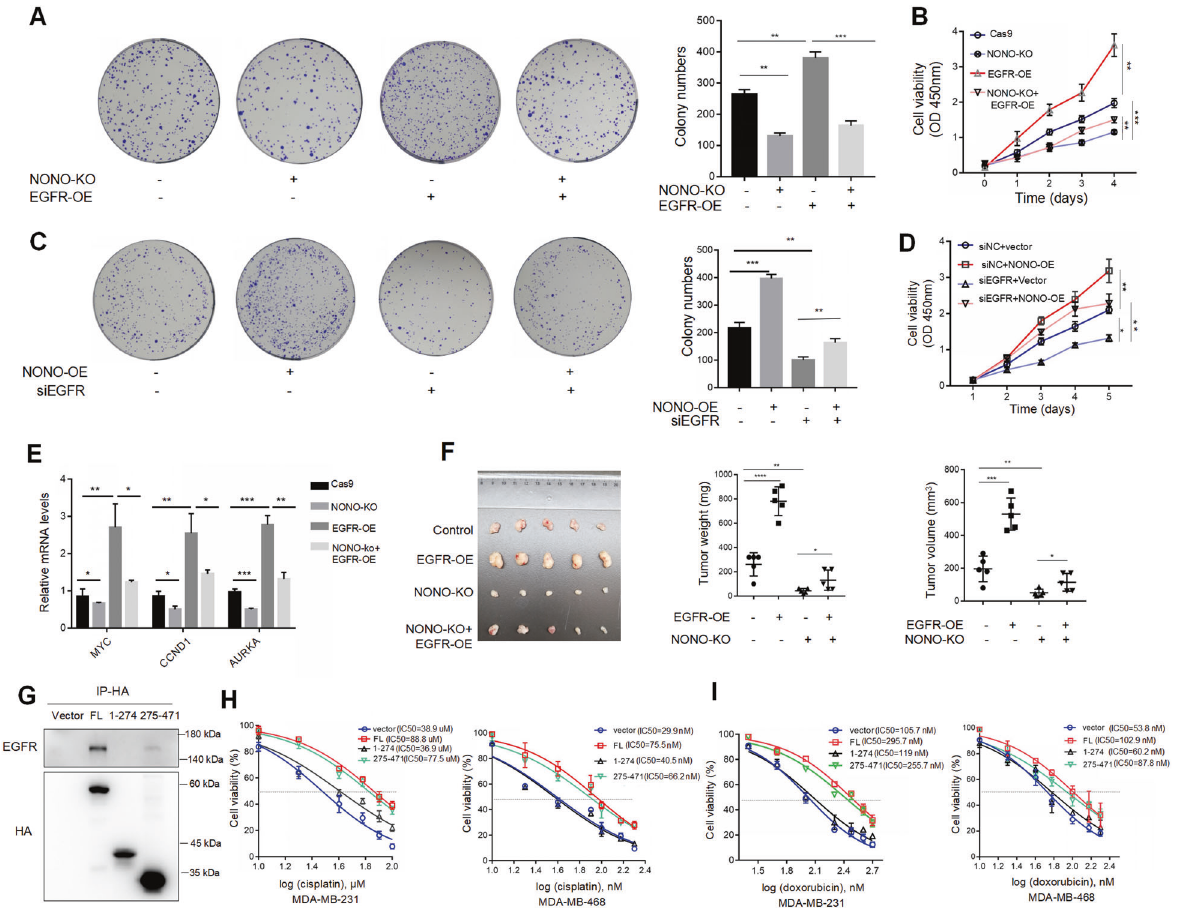
Fig. 7 Nuclear EGFR/NONO complex is important for the malignant progression of TNBC. A Colony formation was used to analyze the effect of overexpressing EGFR on the cell viability of MDA-MB-468 with NONO knockout or not. B CCK-8 was used to analyze the effect of overexpressing EGFR on the cell proliferation of MDA-MB-231 with NONO knockout or not. C Colony formation was used to analyze the effect of overexpressing NONO on the cell viability of MDA-MB-468 with EGFR knockdown or not. D CCK-8 was used to analyze the effect of overexpressing NONO on the cell proliferation of MDA-MB-231 with EGFR knockdown or not. E RT-qPCR was used to analyze the effect of overexpressing EGFR on the mRNA levels of indicated genes in the absence of NONO in MDA-MB-231. F Image of xenograft tumors resected from tumor-bearing mice that injected subcutaneously with indicated cells ( n = 5 per group). G The Functional domain of NONO responsible for the interaction with EGFR was detected by Co-IP. MDA-MB-231 cells with NONO knockout were transfected with full-length, aa 1-274, aa 275-471 fragments or vectors with HA-tag for 48 h, respectively. Then nuclear extracts were incubated with anti-HA beads overnight. Then endogenous EGFR was co-immunoprecipitated and detected by western blotting. H MDA-MB-231 (left) and MDA-MB-468 (right) with NONO knockout overexpressed different fragments of NONO, then treated with indicated concentrations of cisplatin for 24 h. The cells were then analyzed for CCK-8 assay and IC 50 calculation. I MDA-MB-231 (left) and MDA-MB-468 (right) with NONO knockout overexpressed different fragments of NONO, then treated with indicated concentrations of doxorubicin for 24 h. The cells were then analyzed for CCK-8 assay and IC 50 calculation. The displayed results are the mean ± SD. The triplicate measurement results were repeated 3 times and the results were similar. * P < 0.05; ** P < 0.01; *** P < 0.01; **** P < 0.01 versus corresponding